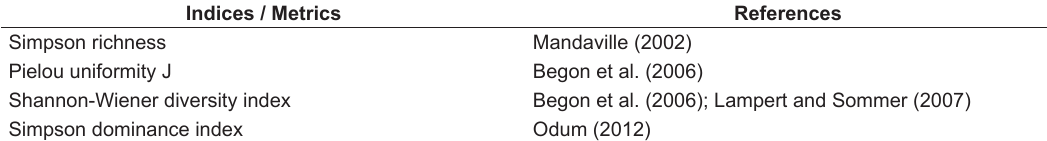
Table 2. Metrics and indexes used to analyze the benthic macroinvertebrates communities.